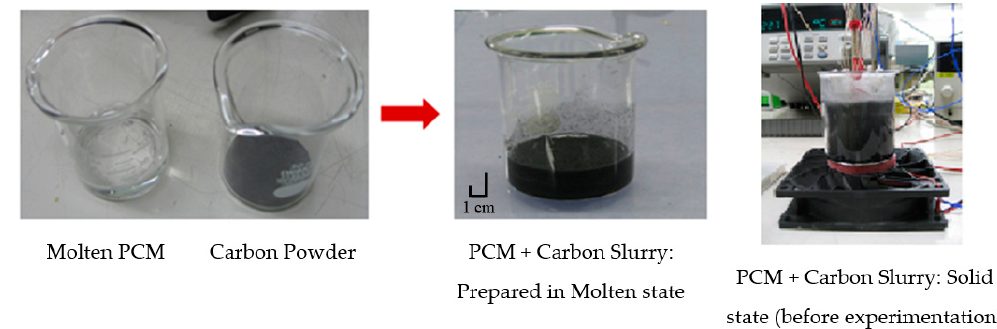
Figure 1. Composite PCM containing PEG-1000 and Carbon. Figure 1 . Composite PCM containing PEG-1000 and Carbon. Figure 1 . Composite PCM containing PEG-1000 and Carbon.